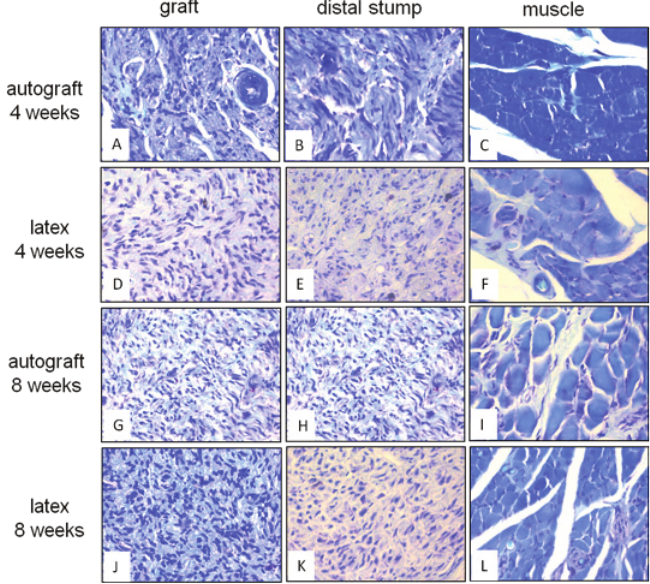
FIGURE 3 - Histograms of ( A ) latency (milliseconds) and ( B ) amplitude (millivolts) obtained by electromyogram. Sciatic nerves of rats transplanted with latex conduits presented higher amplitude and minor latency than those of rats transplanted with autologous nerve, indicating a better functional neurological recovery of animals operated with latex transplants (p<0.05).